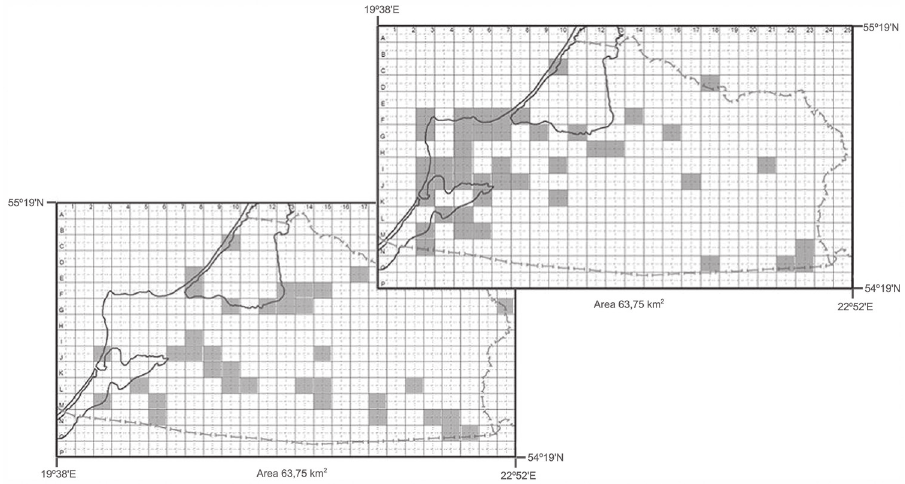
Figure 12. The protected plant species distribution in the territory of Kaliningrad region in the middle of XX century (bottom figure) and early XXI century (top